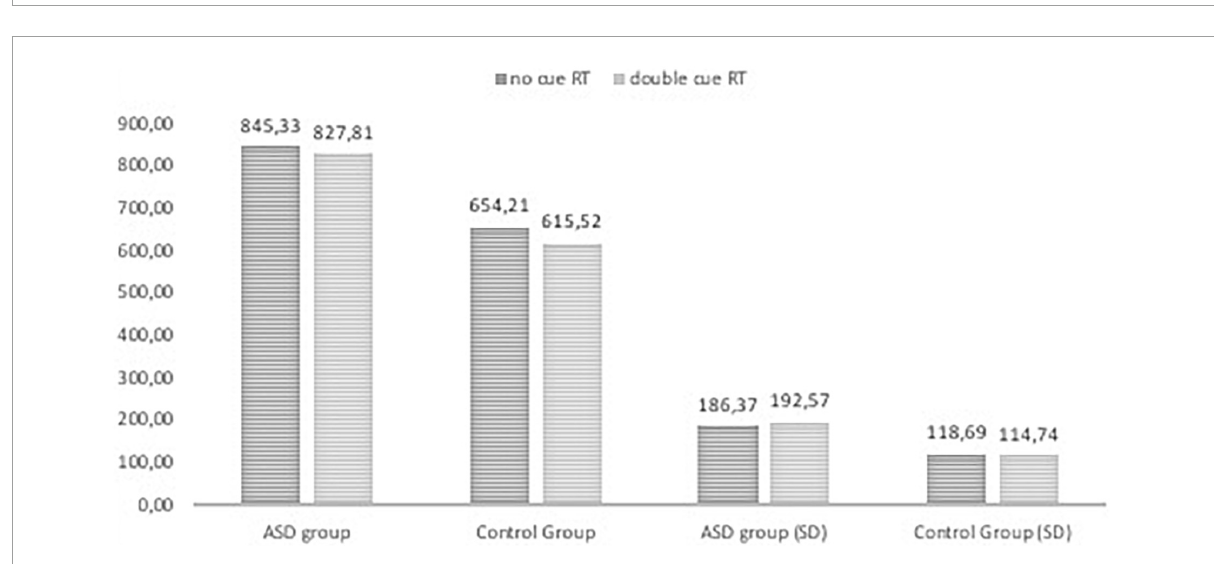
FIGURE4 Reaction time in the ANT tasks with nor cue and doublel cue conditions in ASD group and control